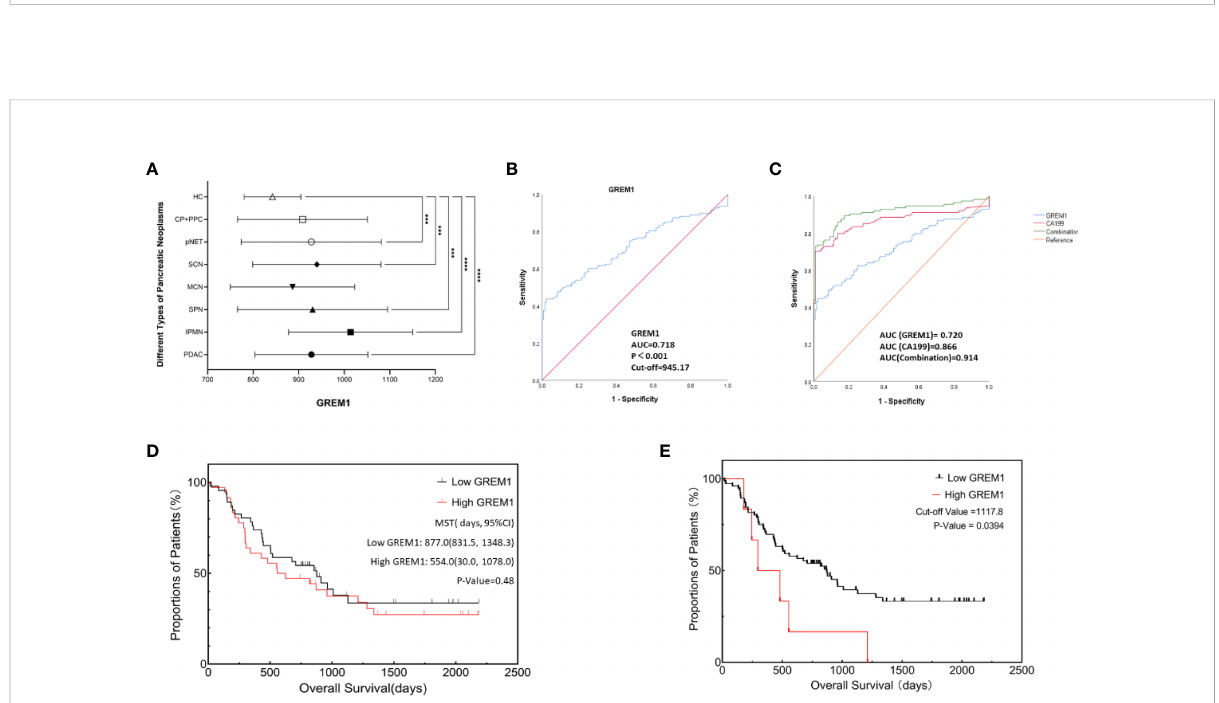
FIGURE 9 Diagnosis and prognosis analysis of serum GREM1 to explore clinical signi fi cance. (A) GREM1 levels in patient serum with different types of pancreatic neoplasms were detected and were all elevated, compared to the healthy control group (HCs, n = 132); these serum samples included pancreatic ductal adenocarcinoma (PDAC; n = 128), intraductal papillary mucinous neoplasm (IPMN; n = 39), pancreatic solid pseudopapillary neoplasm (SPN; n = 47), pancreatic neuroendocrine tumor (pNET; n = 54), serous cystadenoma (SCN; n = 31), mucinous cystadenoma (MCN; n = 26), chronic pancreatitis (CP; n = 11), pancreatic pseudocyst (PPC; n = 4), and healthy control (HCs; n = 132). (B) ROC analysis was performed for GREM1 in 260 cases of PDAC patients (AUC = 0.718, p < 0.001), and the cutoff value was calculated to be 945.17. (C) ROC analysis for GREM1, CA199, and their combinative diagnostic effect (combination value = GREM1 + CA199 * 0.44/0.09, 0.44, and 0.99 are the coef fi cient factors from logistic regression equation, AUC = 0.914 p < 0.001). (D) Survival curves from Kaplan – Meier analysis to compare the low- and high-GREM1 ( p = 0.48). (E) Kaplan – Meier curve for overall survival of PDAC patients based on an optimal cutoff value calculated by X- tile program; OS of high-GREM1 group (n = 6) was signi fi cantly poorer than that of the low-GREM1 group (n = 76), p = 0.0394. ROC, receiver operating characteristic; AUC, area under the curve; CA199, carbohydrate antigen 199; OS, overall survival.#***p < 0.001, ****p <